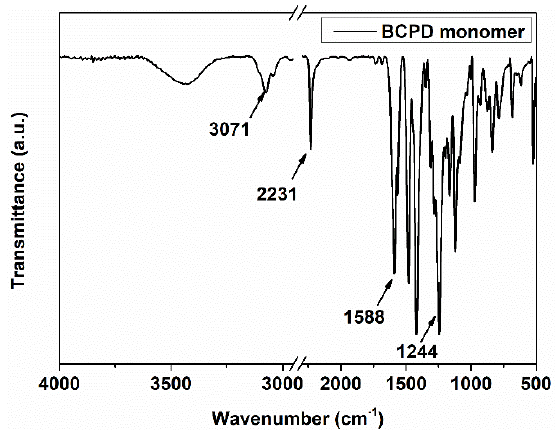
Figure 1. FT-IR spectrum of BCPD monomer.